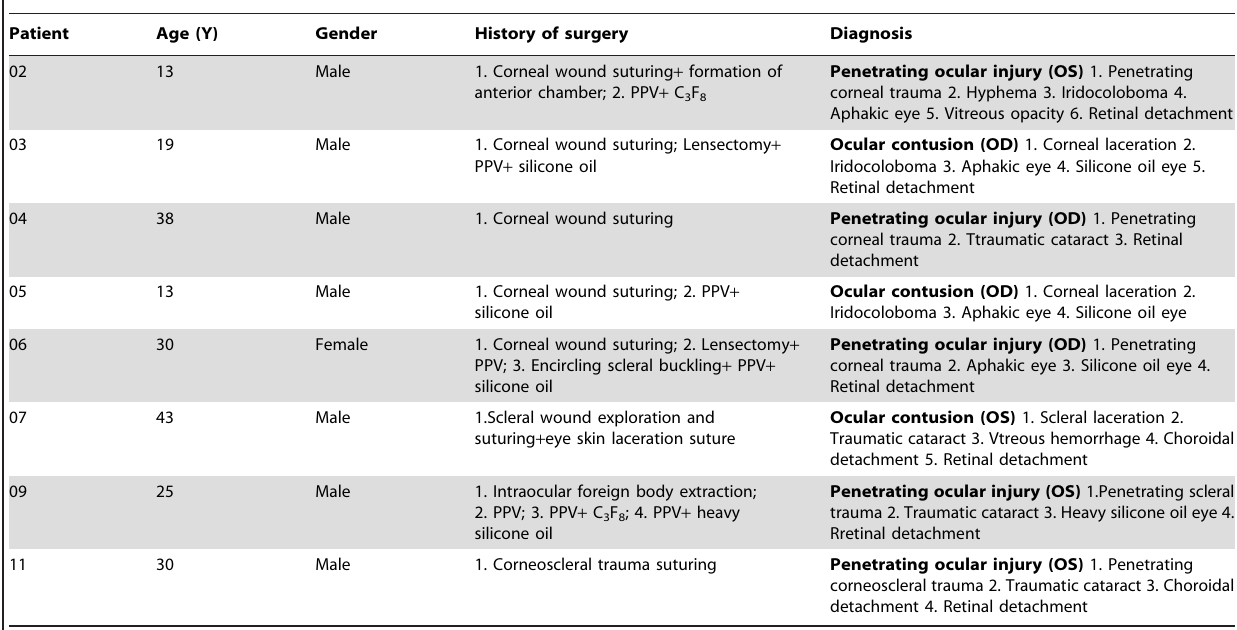
Table 1. Demographic and ocular Characteristics of patients with FCVB implantation.